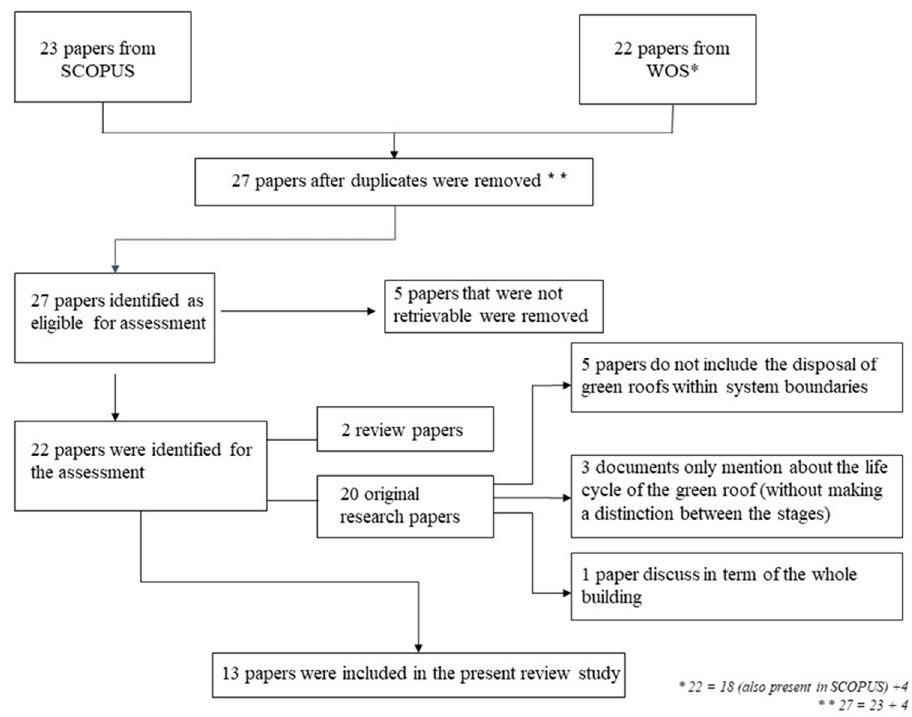
Figure 2. Selection of papers for the literature review.